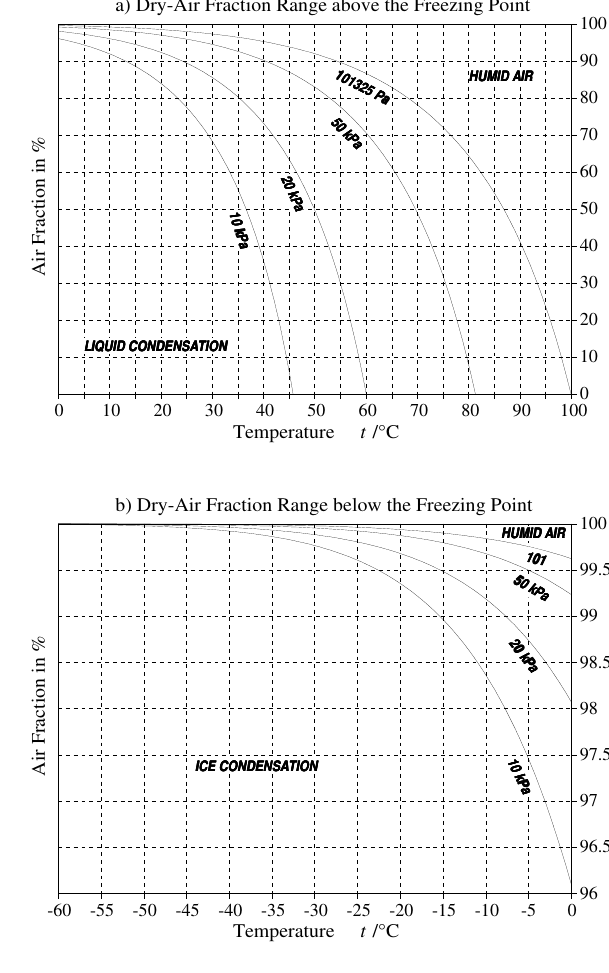
Fig. 5. Saturation curves A sat (T,P) of humid air at the pressures 101.325, 50, 20 and 10kPa, as indicated. Panel (a) shows results for temperatures above the freez- ing point, computed by solving Eq. (5.48) using the library function liq air massfraction air si , Eq. (S21.9), and panel (b) shows results for temperatures below the freez- ing point, computed by solving Eq. (5.70) using the func- tion ice air massfraction air si , Eq. (S25.10). Valid air fraction values A are located above the particular satura- tion curve, A ≥ A sat (T,P) , in the region indicated by “HU- MID AIR”. In the presence of ice-free seawater, the validity range for A is more restricted, A ≥ A cond (S A ,T,P) ≥ A sat (T,P) , by the condensation value A cond , computed from the function sea air massfraction air si , Eq.